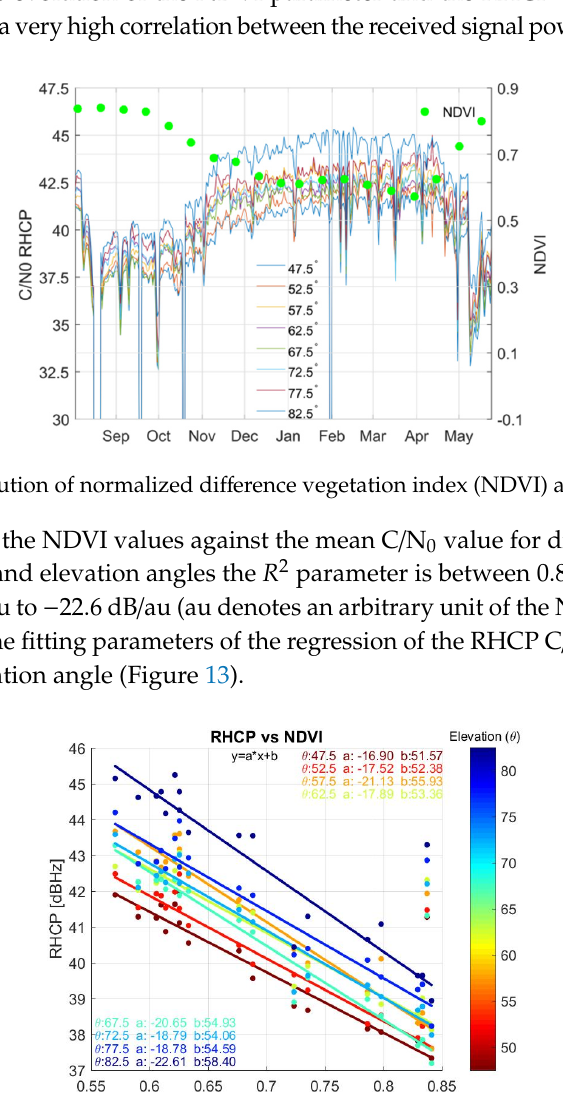
Figure 11. Evolution of LAI and RHCP C/N0.